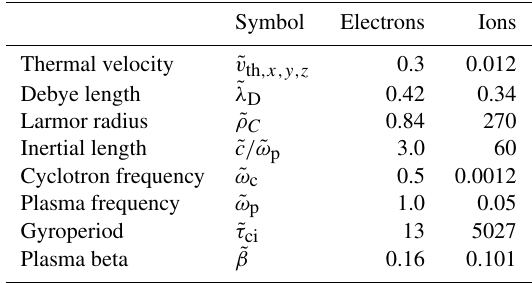
Table 1. Upstream plasma parameters defined for the 2D PIC sim-